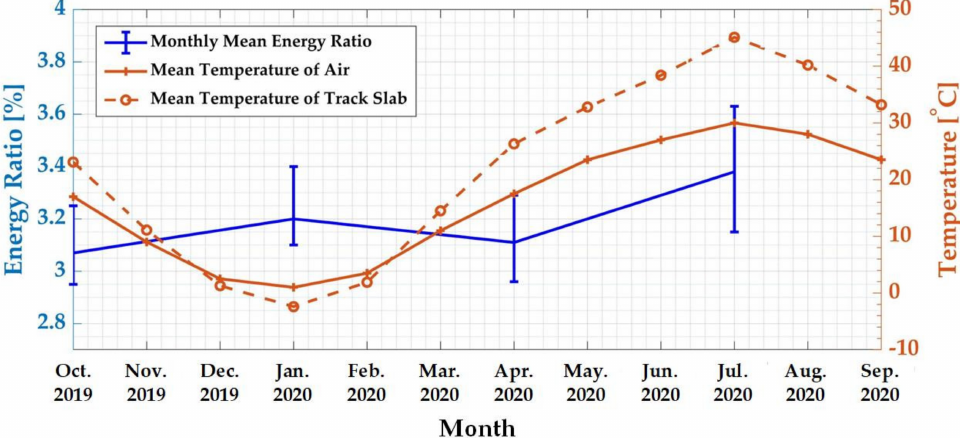
Figure 6. Monthly average wavelet packet transform (WPT) of characteristic frequency band and the monthly mean